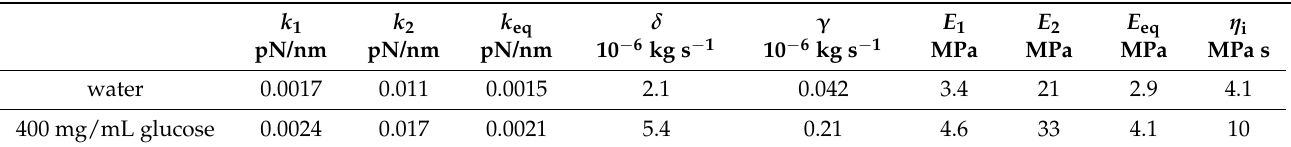
Table 1. Representative values of the mechanical model parameters (stiffnesses k 1,2 and the intrinsic damping coefficient δ ) and the corresponding material properties (elastic moduli E 1,2 , and the intrinsic viscosity η i ) are evaluated for pure water and dense glucose solution conditions. The equilibrium stiffness k eq is calculated as: 1/ k eq = 1/ k 1 + 1/ k 2 . The equilibrium elastic modulus E eq is obtain analogously.